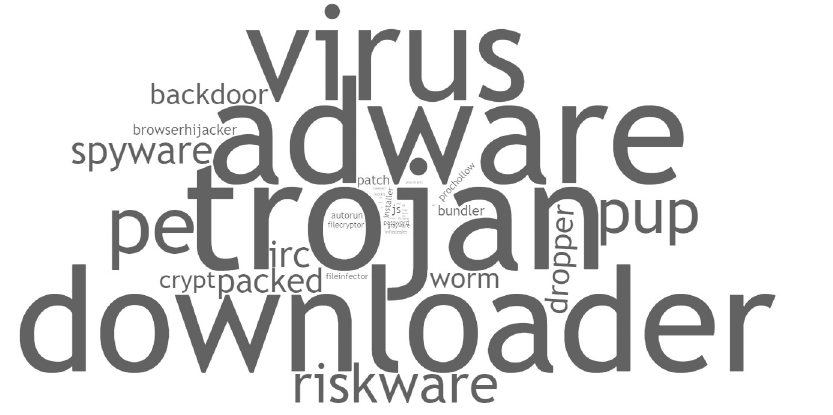
Fig 6. The tag cloud of ramnit.